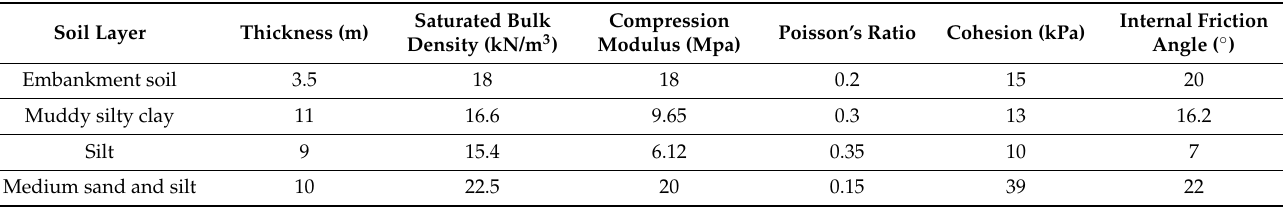
Table 2. Mechanical properties of soil used in this study.